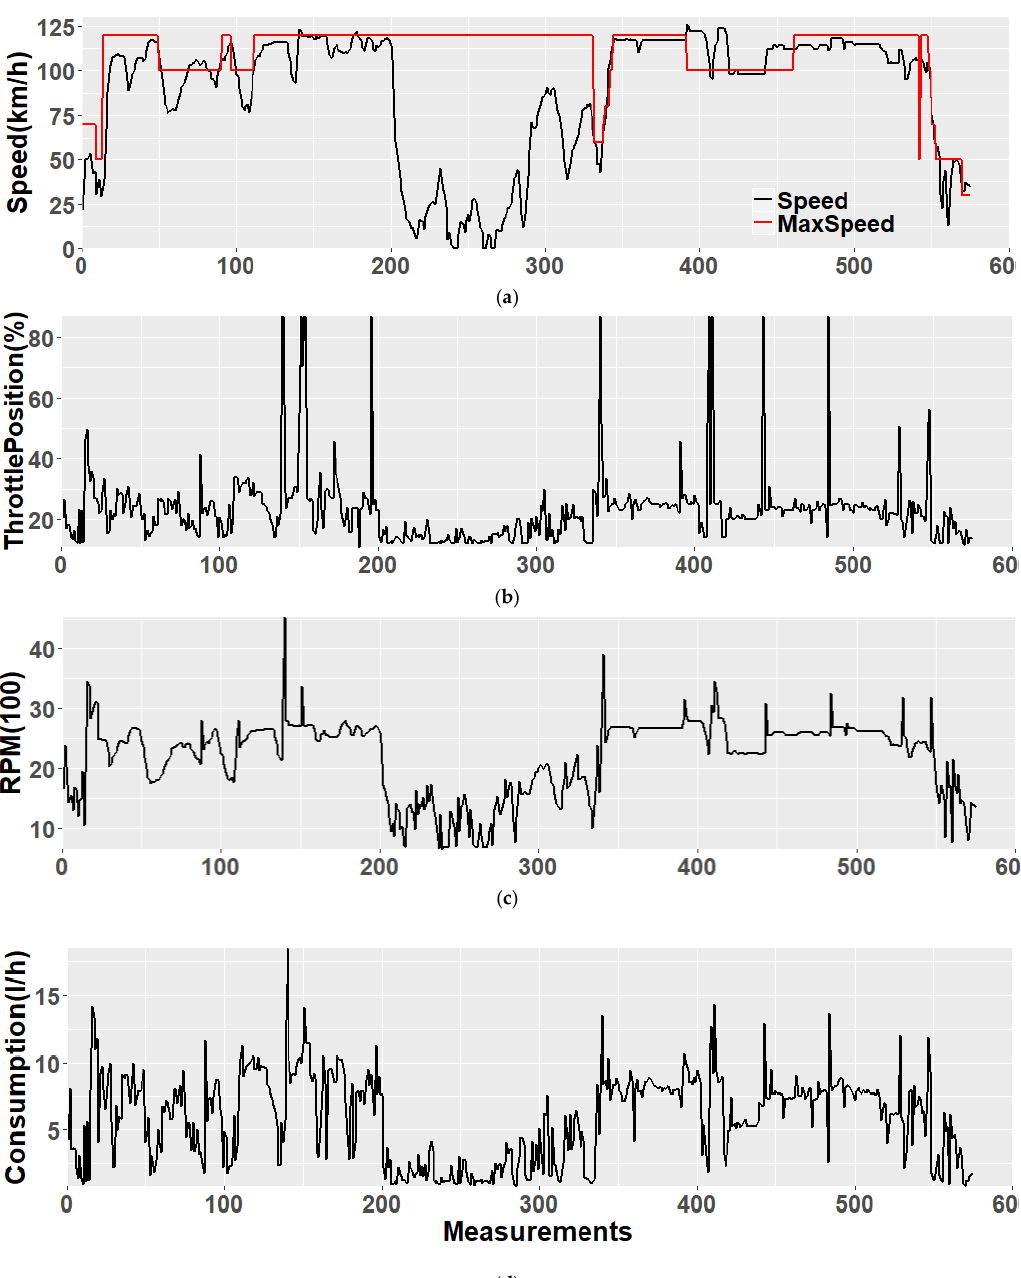
Figure 6. Performance for an example trip. Speed (also compared with the OSM speed limit in red) ( a ), throttle position ( b ), RPM ( c ) and fuel consumption ( d ). For all the sub-figures, the horizontal unit is the ordinal sample (measurement) number where the Sampling interval is 5 s.